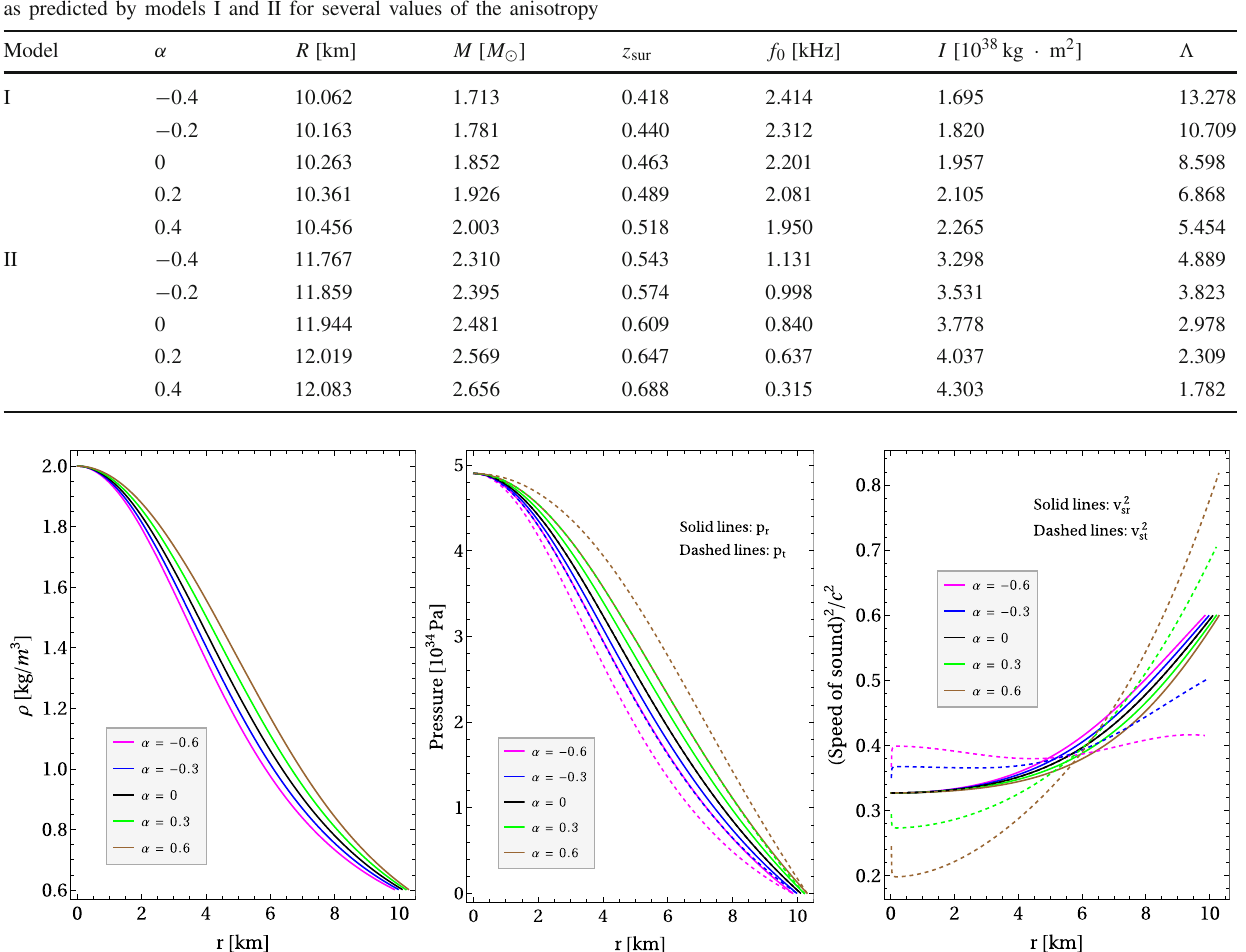
Table 2 Radius, mass, redshift, fundamental mode frequency ( f 0 = ν / 2 π ), moment of inertia and dimensionless tidal deformability of 0 dark energy stars with central energy density ρ c = 1 . 5 × 10 18 kg/m 3